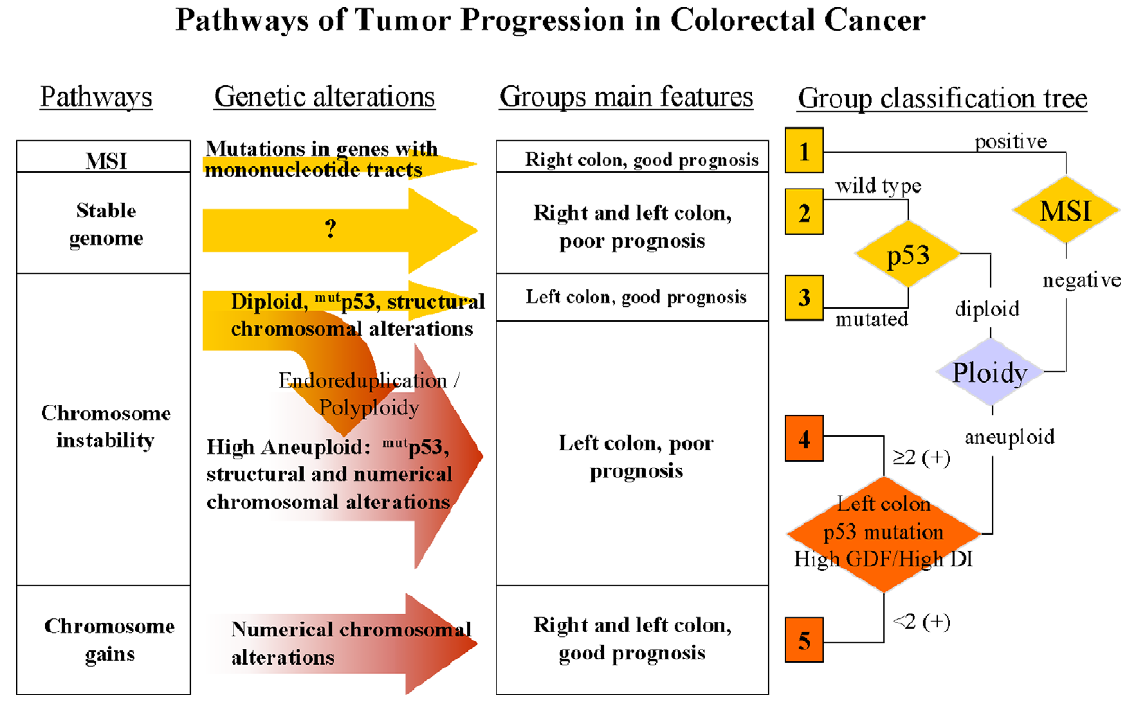
Fig. 1. Scheme of the hypothesized genetic pathways of tumor progression in colorectal cancer based on a model integrating different forms of genomic instability. Each pathway is depicted according to the approximate percentage of cases displaying a given type of genetic damage. The main features of each group and the proposed decision tree used to assign each case to the groups are